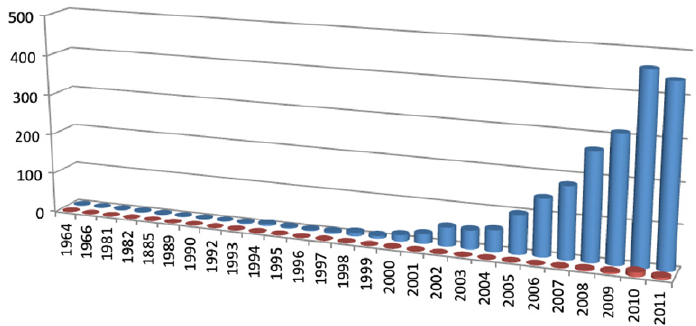
Figure 1. ‘‘The first publication on epigenetics was in 1964, yet progress has been slow until the advent of high throughput technologies in the early 21 st century. As of 10 th November 2011 more than 2,100 publications with the term ‘‘epigenetics’’ in their title or abstract were available in PubMed (blue bars). However, the role of epigenetics in molecular cardiology is only starting to emerge (search terms ‘‘epigenetics heart’’ in title or abstract (red bars)).’’